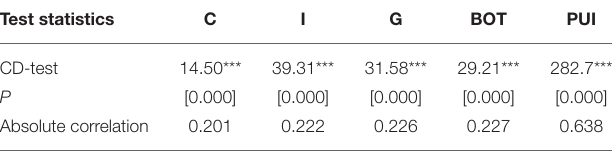
TABLE 1 | Summary of descriptive statistics & correlation matrix. Variable